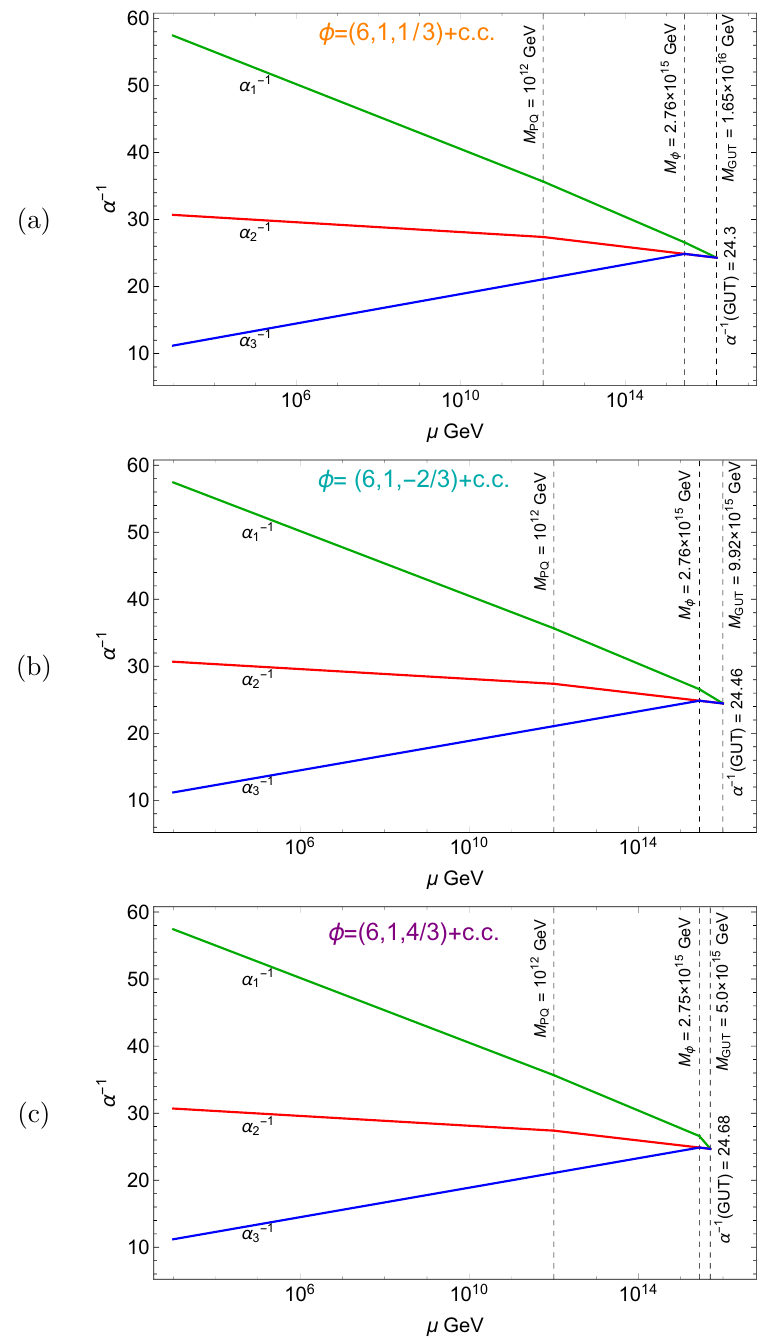
Figure 3 . Evolution of gauge couplings including e(cid:11)ects of a second pair of Higgs doublets at M PQ = 10 12 GeV. A color sextet (cid:12)eld ( (cid:30) ) and its conjugate is assumed to have a mass slightly below the GUT scale, with the mass scale chosen to restore uni(cid:12)cation of gauge couplings. The three plots correspond to the three color sextet choices (a) (6 ; 1 ; 1 = 3), (b) (6 ; 1 ; with each threshold e(cid:11)ect listed in table 7. For this illustration, we set M SUSY = 1 TeV and used the one-loop RG evolution of gauge couplings.